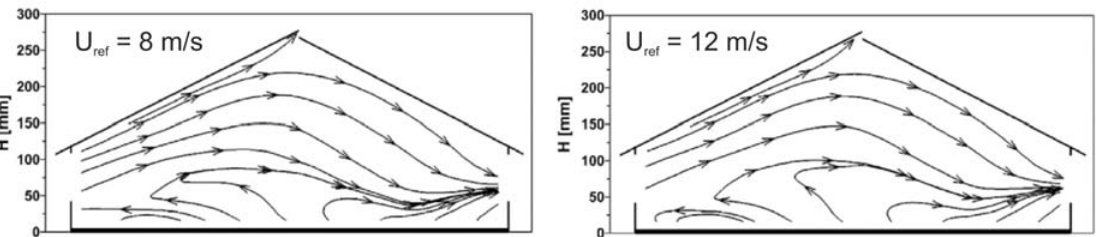
Figure 2. Internal Reynolds number independence test within a dairy building for two wind tunnel freestream velocities: 8 m/s (left) and 12 m/s (right). Note that the streamlines (lines with arrows) do not change significantly with the change in the approach wind speed (freestream velocity). Adapted from [26]—Copyright 2018,